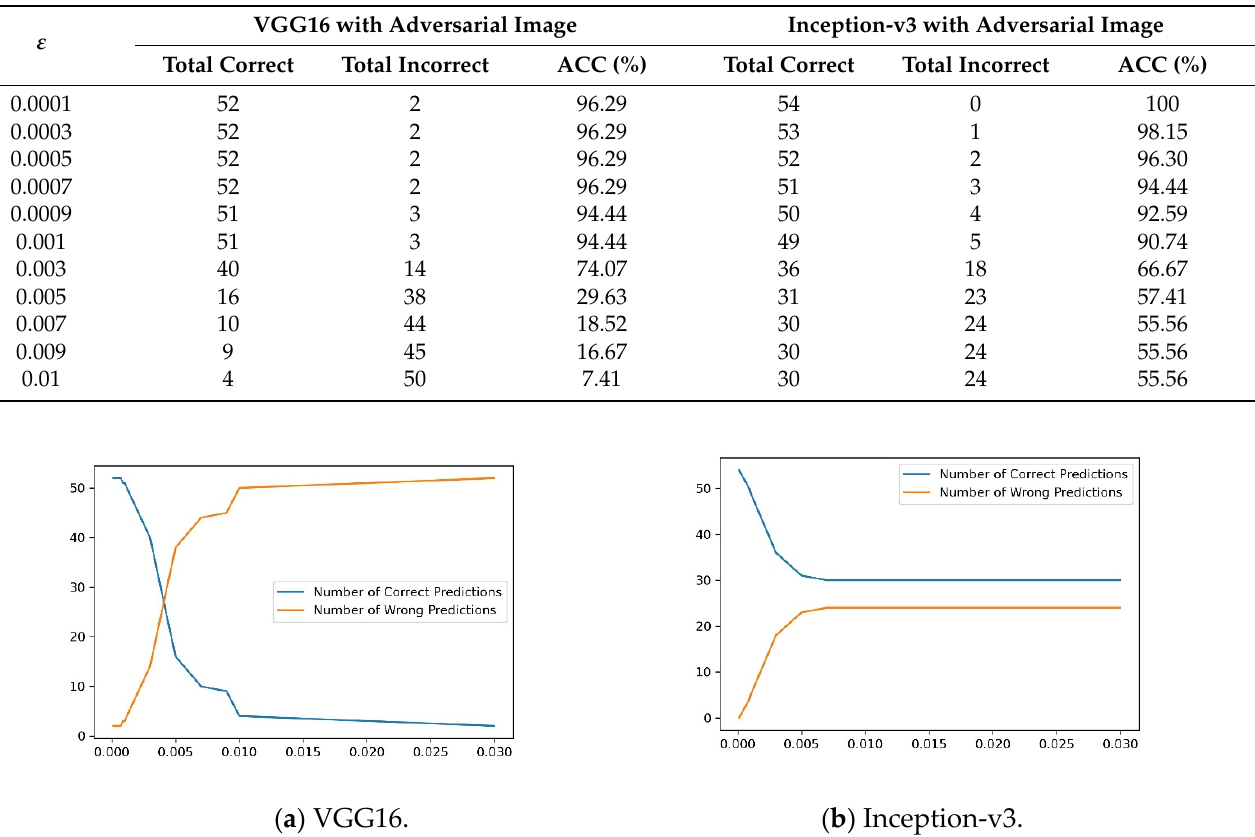
Figure 7. Performance for different ε of FGSM attack in chest X-ray